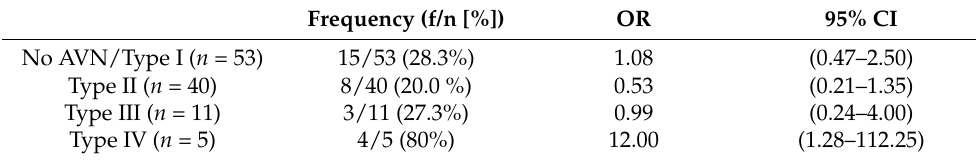
Table 5. The risk of leg length corrective intervention, stratified for the AVN